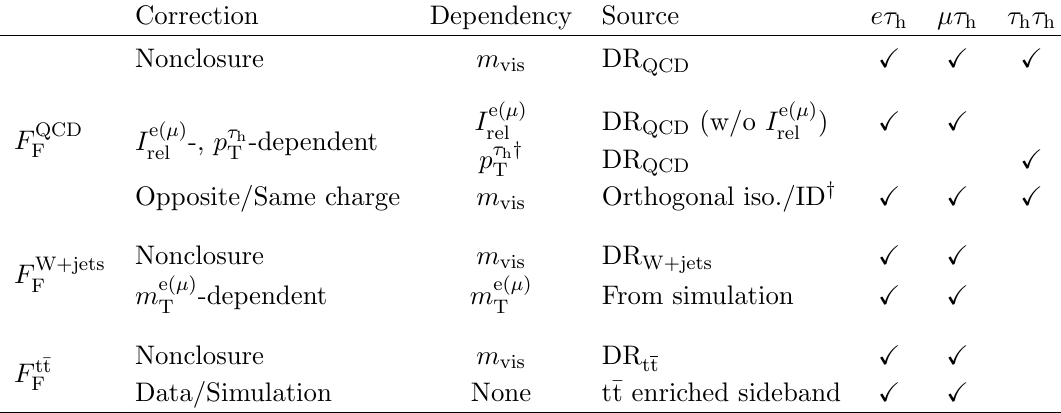
, F W+jets , and F tt as described in the text. In the fourth F F F